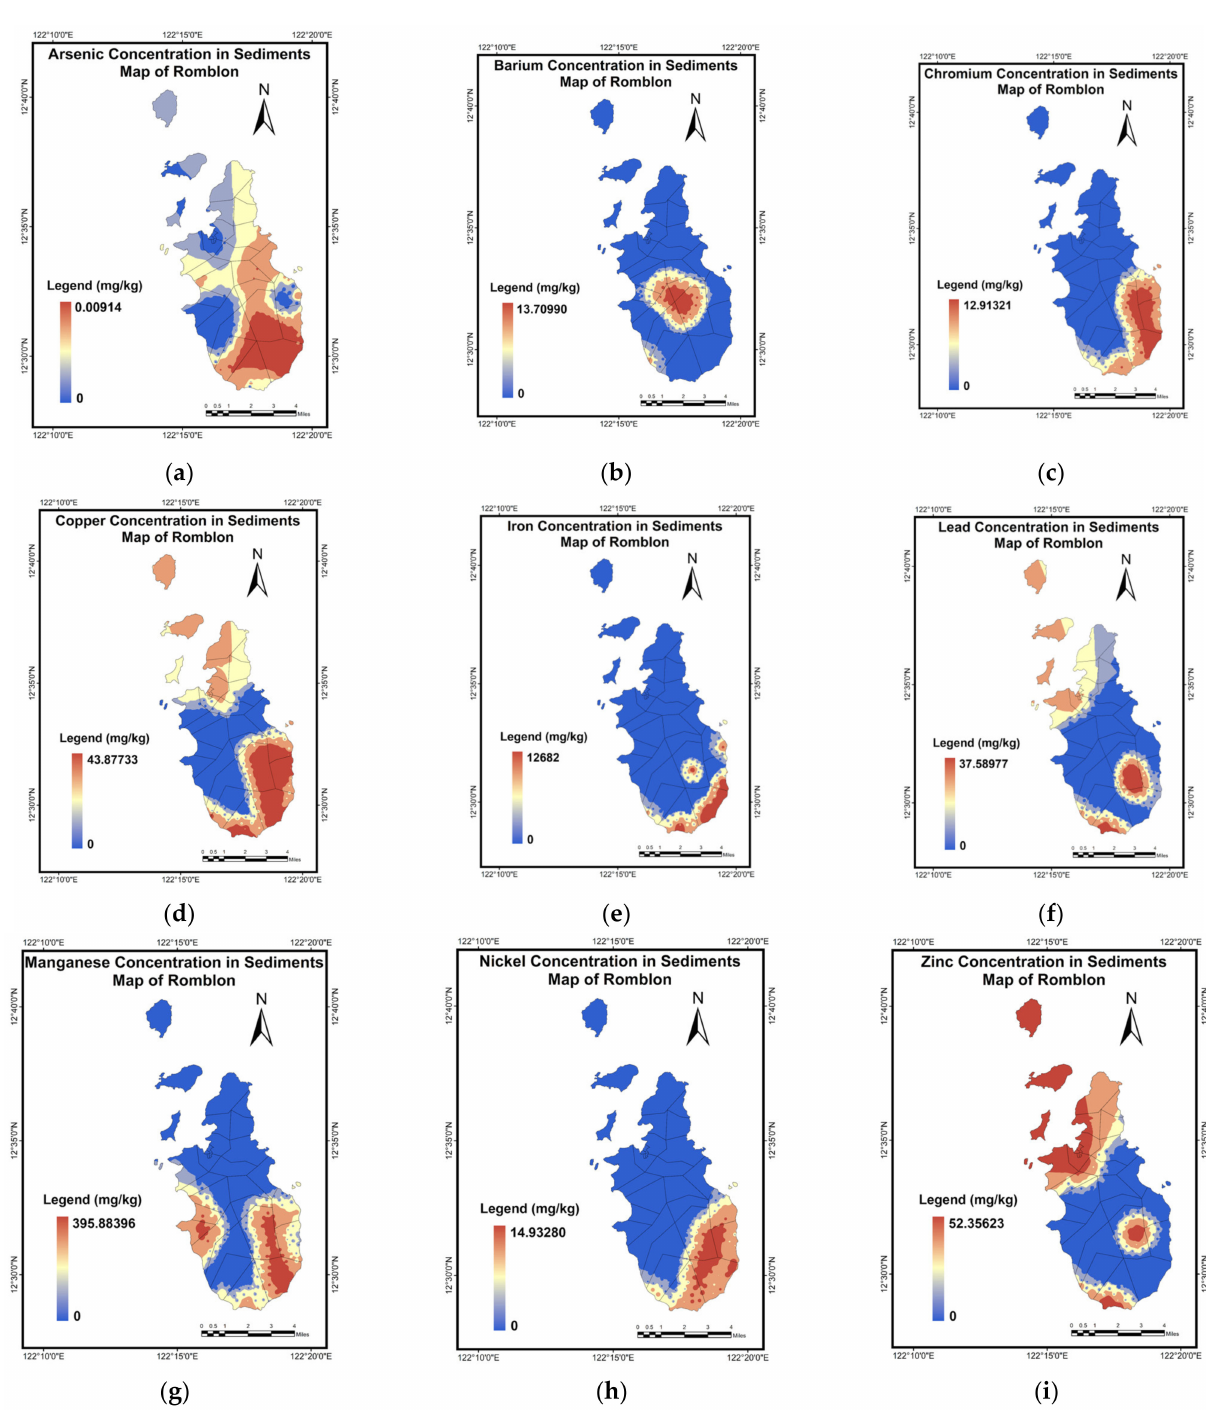
Figure A1. Heavy metal concentration of sediments: ( a ) Arsenic, ( b ) Barium, ( c ) Chromium, ( d ) Copper, ( e ) Iron, ( f ) Lead, ( g ) Manganese, ( h ) Nickel, ( i )